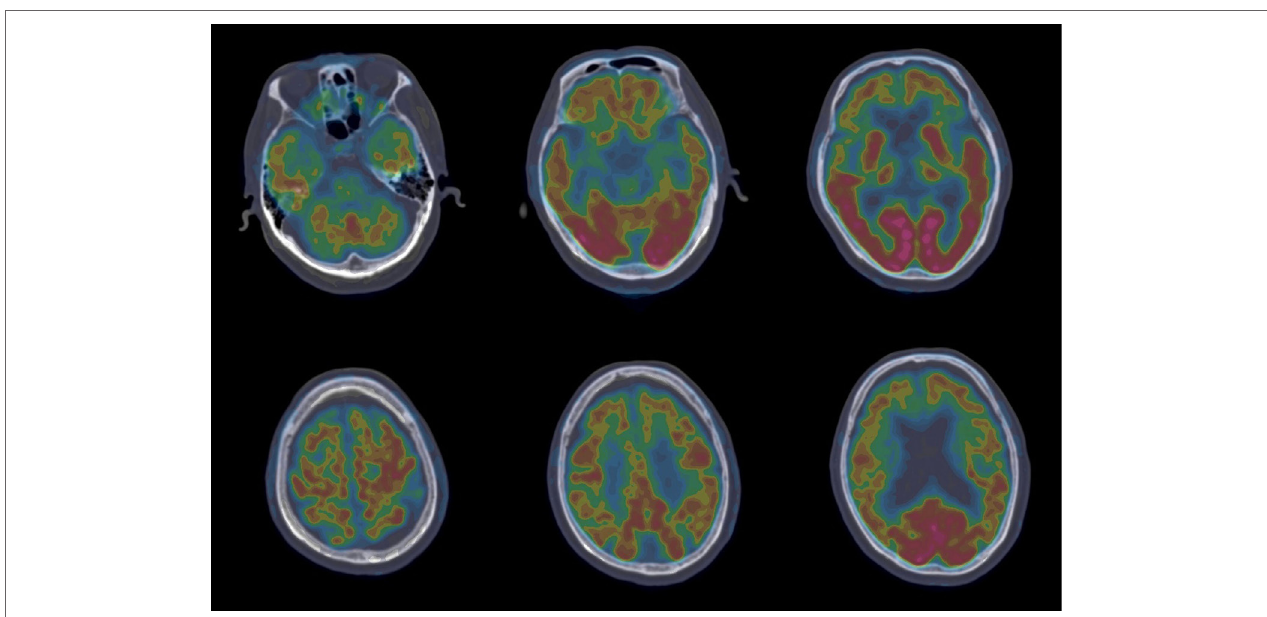
FIgURe 2 | 18F-FDG-PET revealed hypometabolism of the bilateral frontal, temporal, and parietal lobes that was more prominent on the frontal